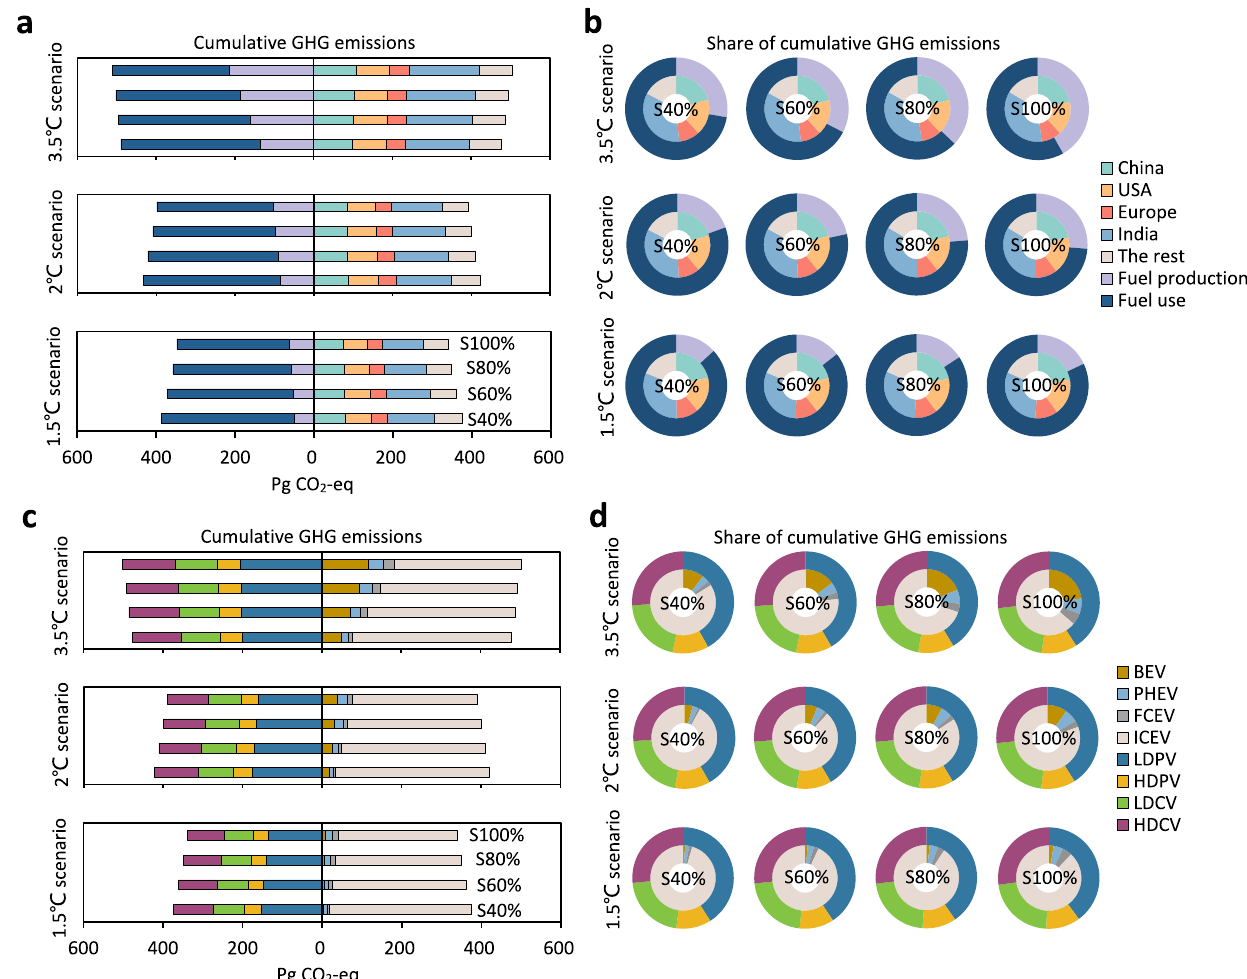
Fig. 6 | Comparison of cumulative road transportation fuel greenhouse gas (GHG) emissions.a , b Cumulative GHGemissions (Pg CO 2 -eq yr − 1 ) breakdownand sharebasedonfuelproductionanduseandcountriesinvestigated. c , d Cumulative GHG emissions (Pg CO 2 -eq yr − 1 ) breakdown and share based on fuel powertrain